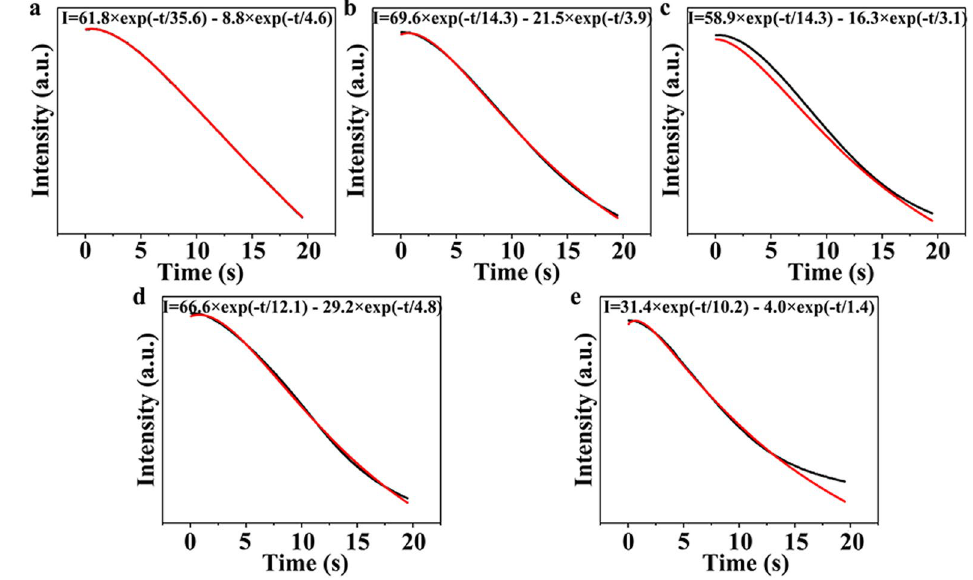
Figure 4. Photobleaching process exposed to different selenium contents, and the bi-exponentials ( I = a 1 exp[ − t/ τ 1 ] + a 2 exp[ − t/ τ 2 ]) fitted line. The red line represents the fitted data and the dark line represents experiment values. ( a ) Se1Cd2, ( b ) Se2Cd2, ( c ) Se3Cd2, ( d ) Se4Cd2, ( e ) Se5Cd2.